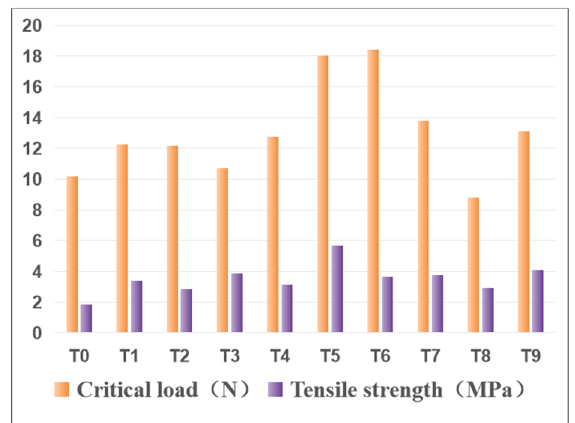
Figure 8. ( a ) (T1) scratch behavior ; ( b ) (T2) scratch behavior ; ( c ) (T3) scratch behavior ; ( d ) (T4) scratch behavior ; ( e ) (T5) scratch behavior ; ( f ) (T6) scratch behavior ; ( g ) (T7) scratch behavior ; ( h ) (T8) scratch behavior ; ( i ) (T9) scratch behavior ; ( j ) (T0) scratch behavior .